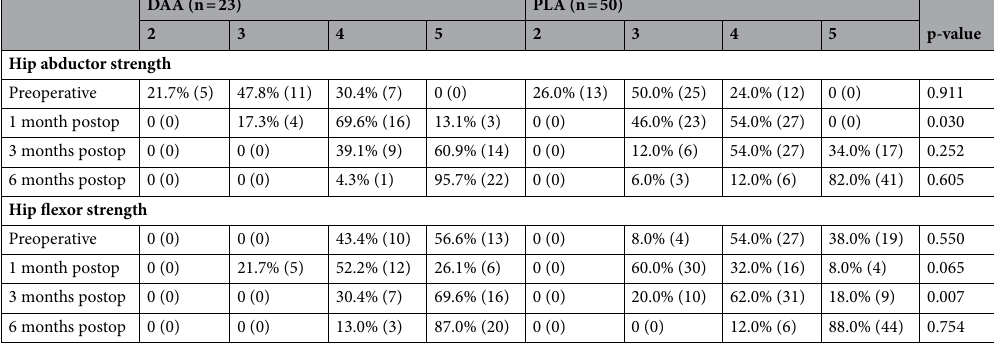
Table 3. Changes in hip abductor and flexor strength before and after THA in the two cohorts.